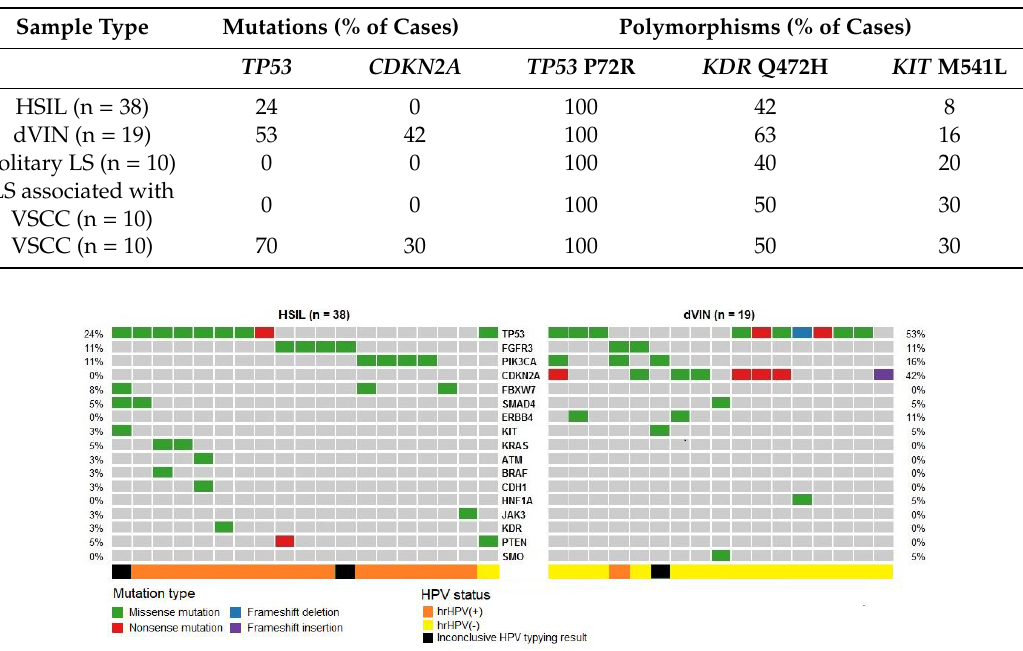
Figure 2. Distribution of pathogenic mutations and variants of uncertain significance in vulvar premalignant lesions. Samples were classified as HSIL (n = 38) and dVIN (n = 19) based on histopathological and IHC assessment. Each column corresponds to an individual tumor case, while each row corresponds to the mutated gene. Samples with no mutations detected are depicted in grey, missense mutations are highlighted in green, whereas red hits indicate nonsense mutations, indel mutation are violet and blue. hrHPV-positive and hrHPV-negative samples are marked in the bottom line with orange and yellow color,